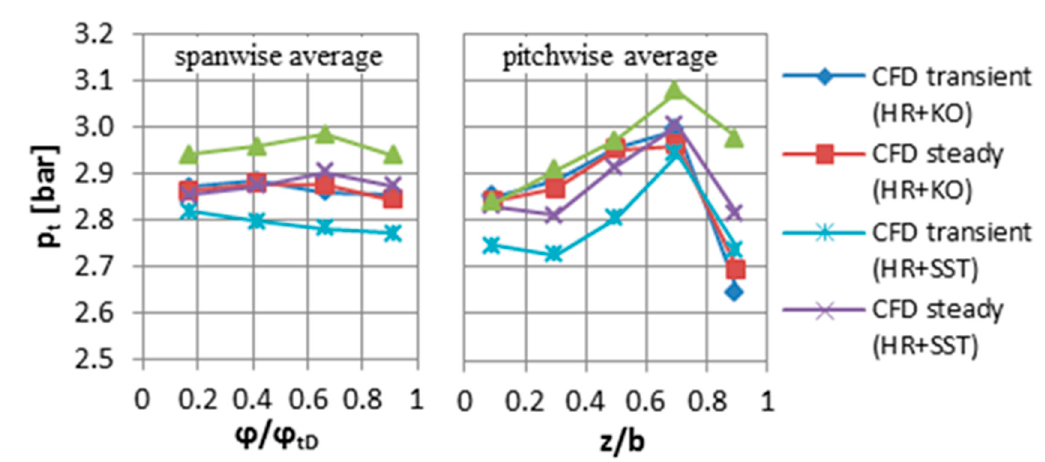
Figure 7. Total pressure at 2M section, point P1